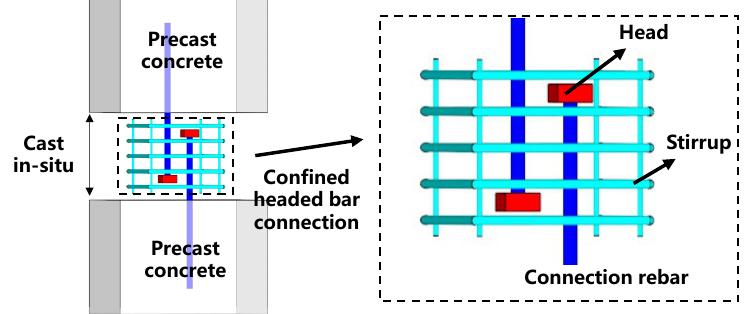
Figure 1. Confined headed bar connection (CHBC).